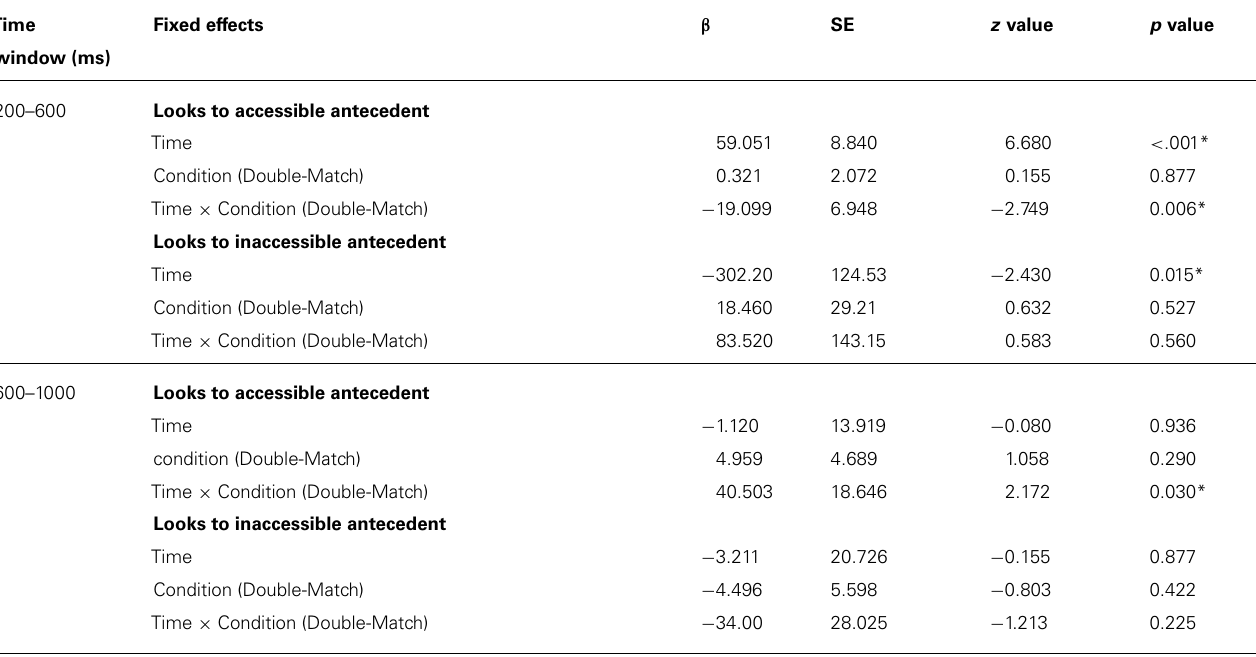
Table 4 | Main effect of Condition andTime × Condition interactions from best fitting models fit to looks to each